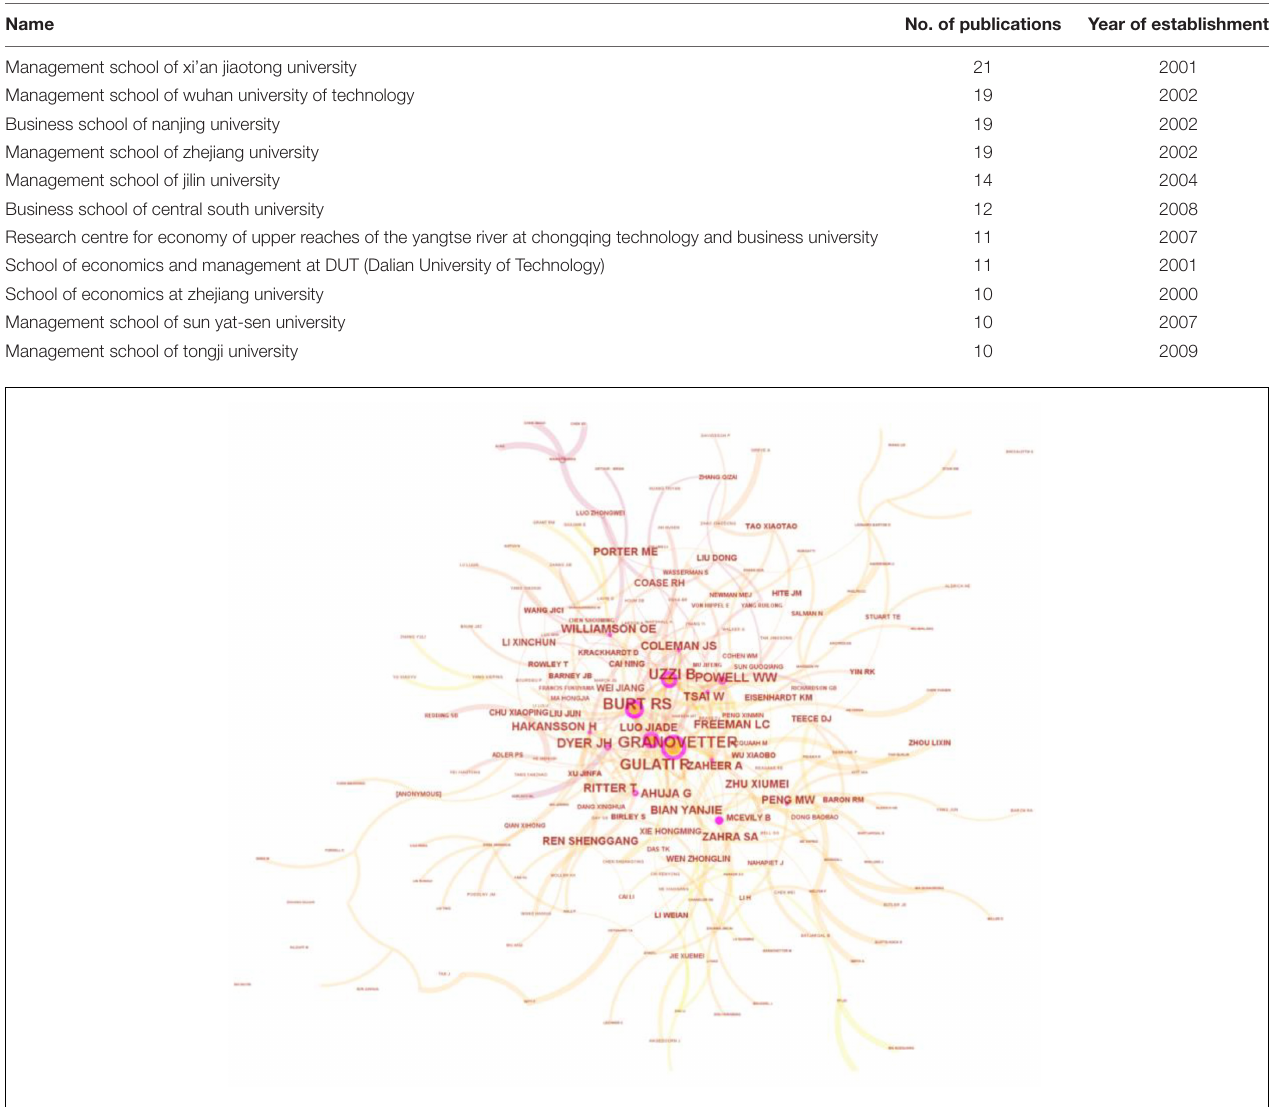
TABLE 3 | Core research institutions of EN studies in China.